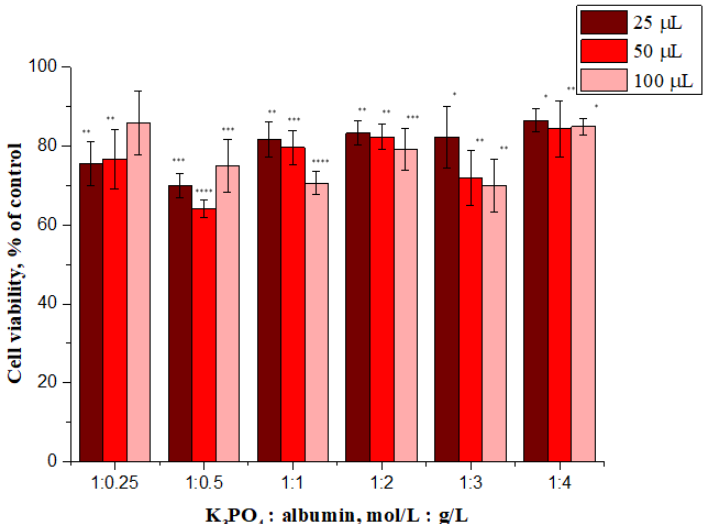
Figure 10. In vitro cytotoxicity of albumin nanoparticles ( samples 1–6 ) to NHDF cells after incubation at 48 h. * show the statistical significance calculated with one-way analysis of variance (ANOVA) and the Dunnet post hoc test (* p ≤ 0.05, ** p ≤ 0.01, *** p ≤ 0.001 and **** p ≤ 0.0001), as compared to control (not treated cells).